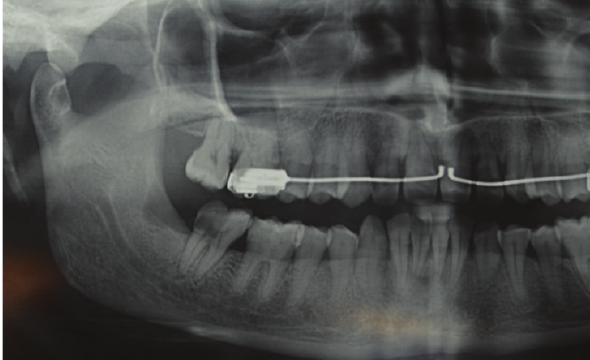
Figure 4: Clinical healing after surgical